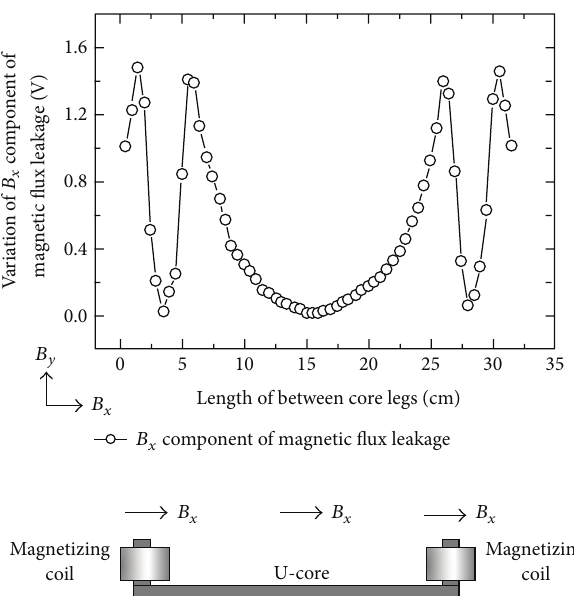
Figure 6: Variation of the 𝐵 𝑥 component of the magnetic flux leakage without sample between core